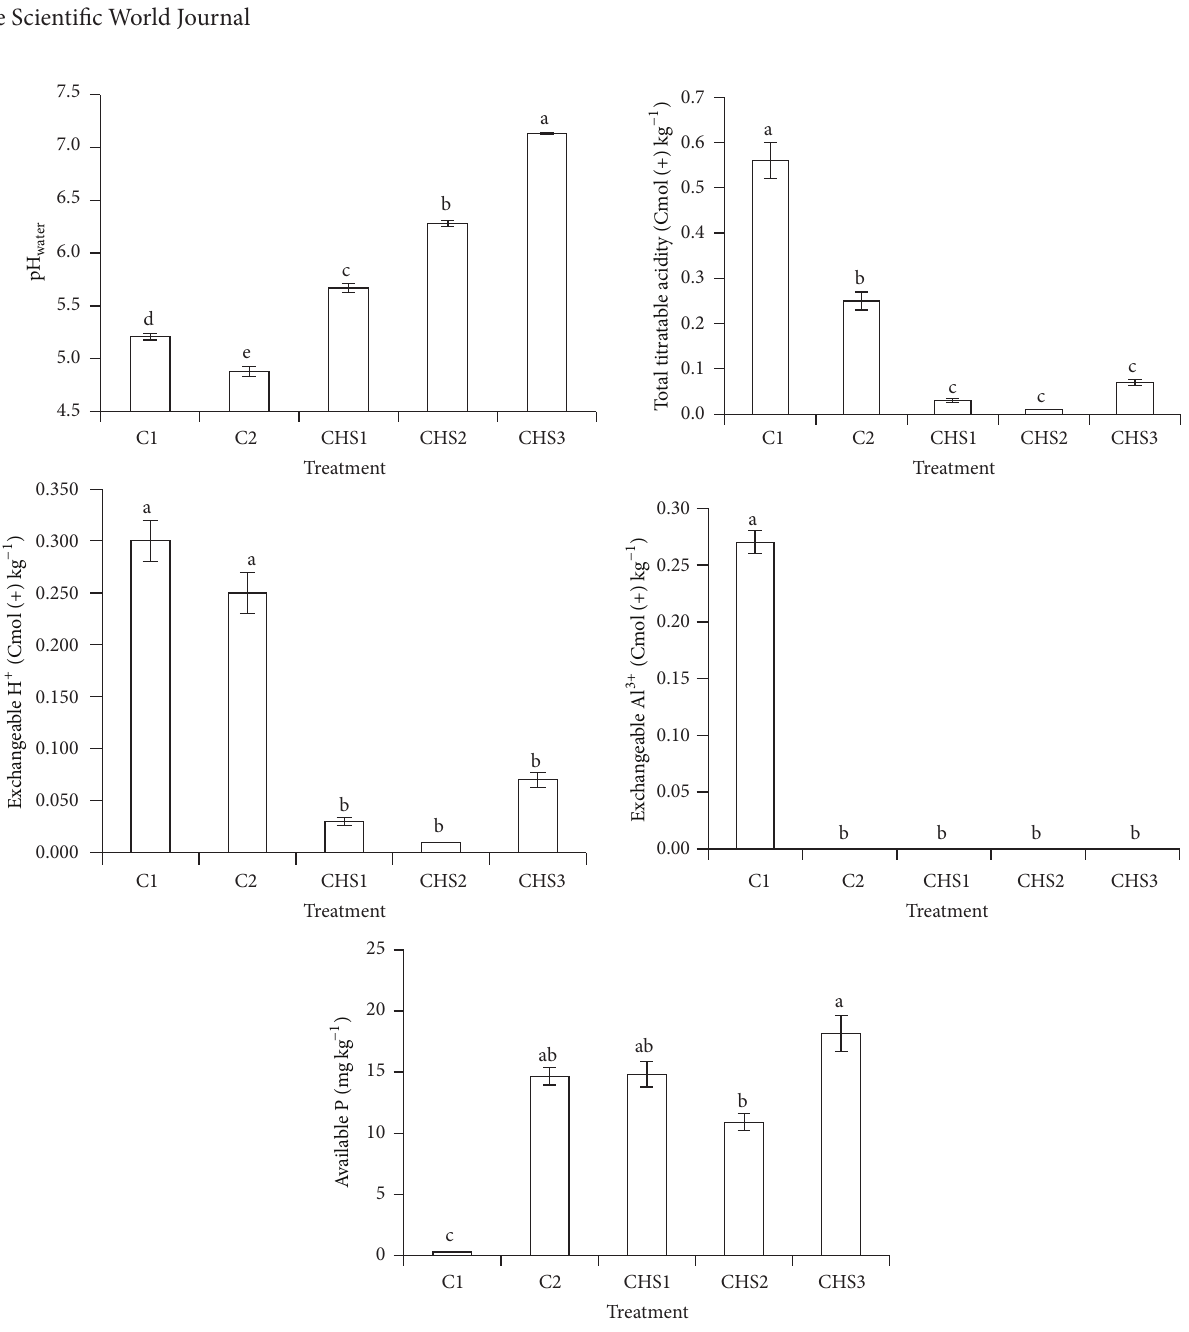
Figure 7: Treatments (C1: soil alone, C2: soil + complete fertilization, CHS1: soil + complete fertilization + 20 g rice straw compost + 2 g sawdust ash, CHS2: soil + complete fertilization + 40g rice straw compost + 4g sawdust ash, and CHS3: soil + complete fertilization + 60 g rice straw compost + 6 g sawdust ash) effect on soil pH, total titratable acidity, exchangeable H + , exchangeable Al 3+ , and available P content at 90 days after seeding. Different alphabets indicate significant difference between means using Tukey’s test at 𝑃 ≤ 0.05 . The error bars are the ± standard error of